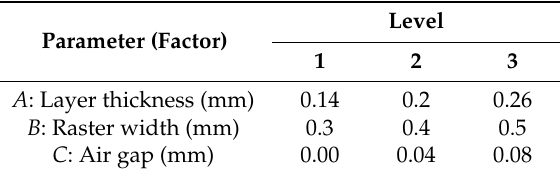
Table 1. Process parameters and their